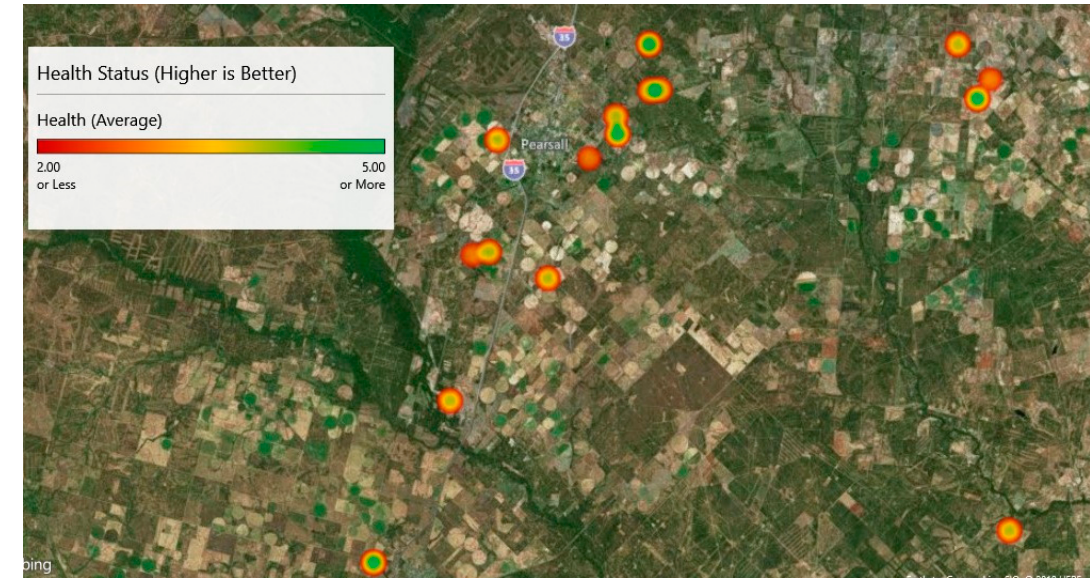
Figure 4. Health status heat map.